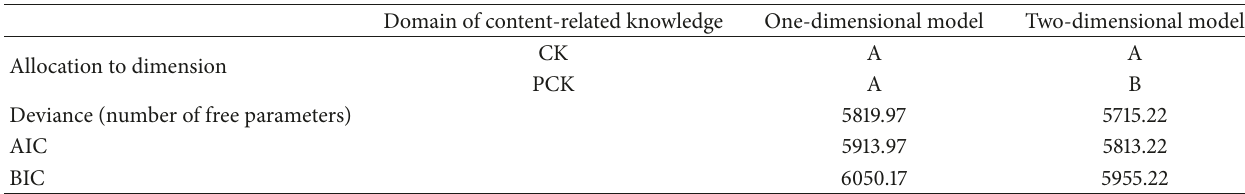
Table 3: Final deviance and information-based criteria for different partial credit models of content-related knowledge.